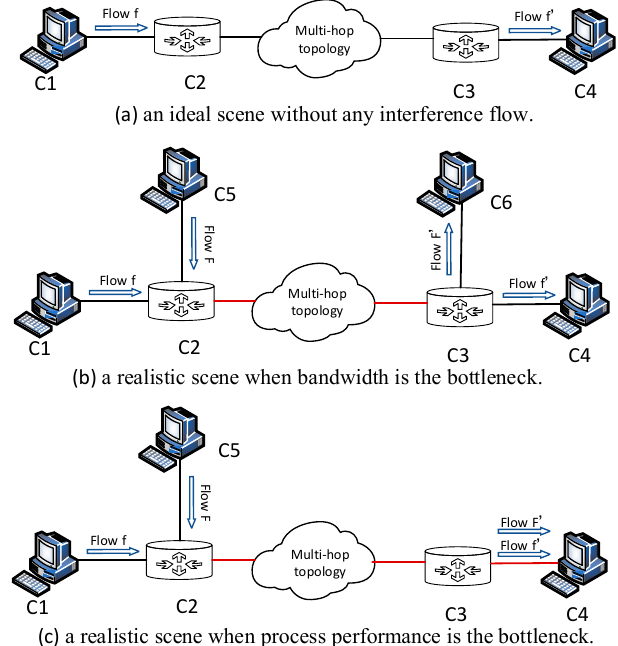
Figure 7. The experimental network